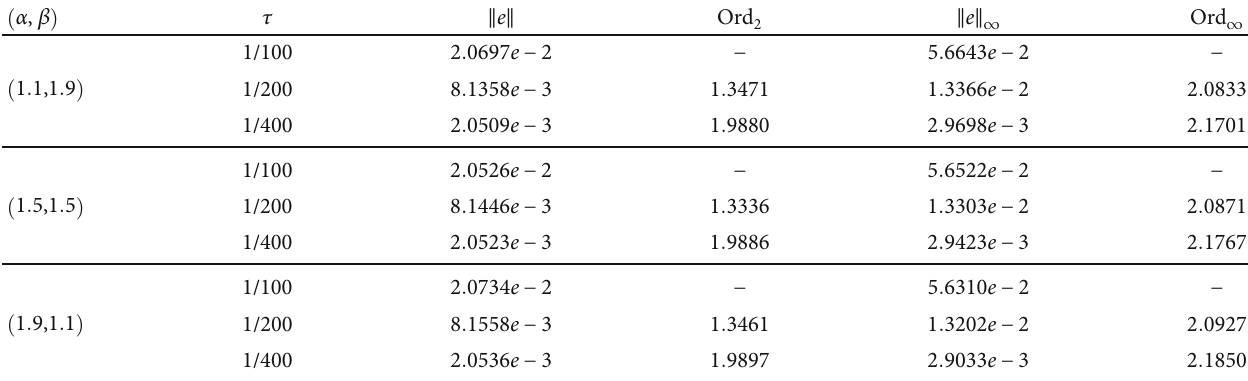
Table 4: l 2 -and l ∞ -errors and their convergence orders of (28) – (30) for 1 < α < 2 in the temporal direction for (73) with h = 1/1000 for Example